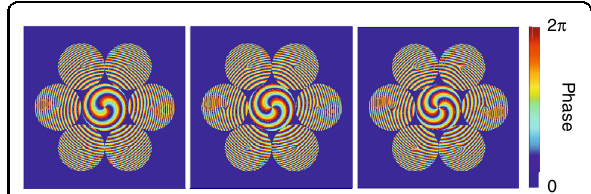
Fig. 7 The vortex phase plate diagrams for generating 7-core OAM modes. Each represents topological charge of l = + 2, + 3, and +